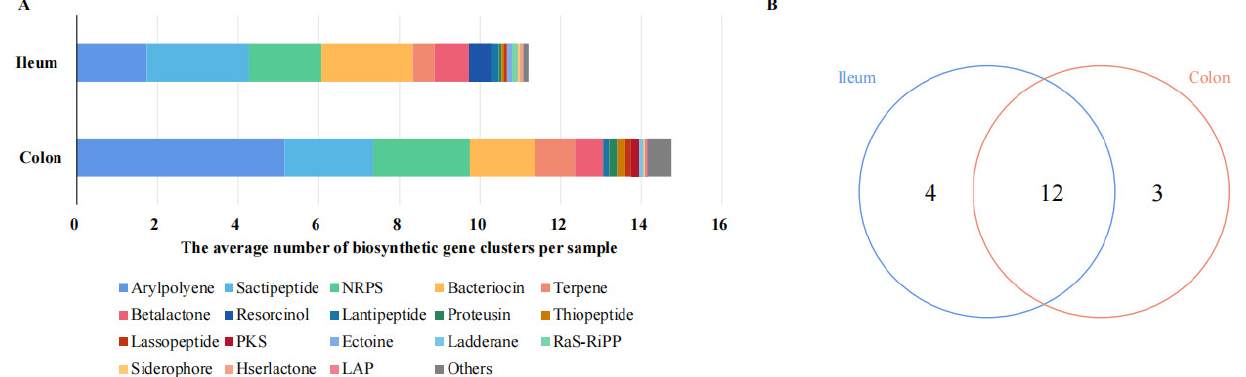
Figure 1. The distribution of BGCs in the porcine intestine. ( A ) The average number of BGCs per sample in the ileal and colonic microbiomes; ( B ) Venn diagram of the specific and shared BGCs in the ileal and colonic microbiomes.